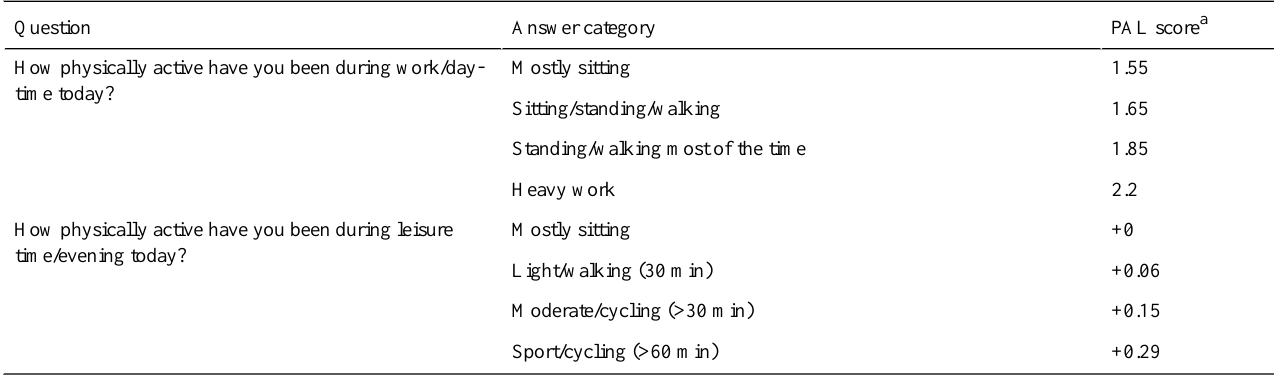
Table 1. The two questions administered daily by the smartphone application and their corresponding physical activity level (PAL) value